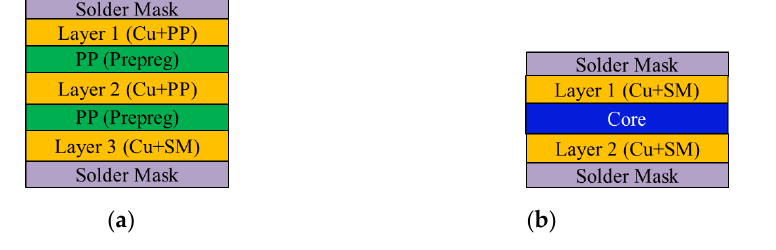
Figure 2. Schematic cross-sectional view: ( a ) top coreless substrate; ( b ) bottom core interposer.